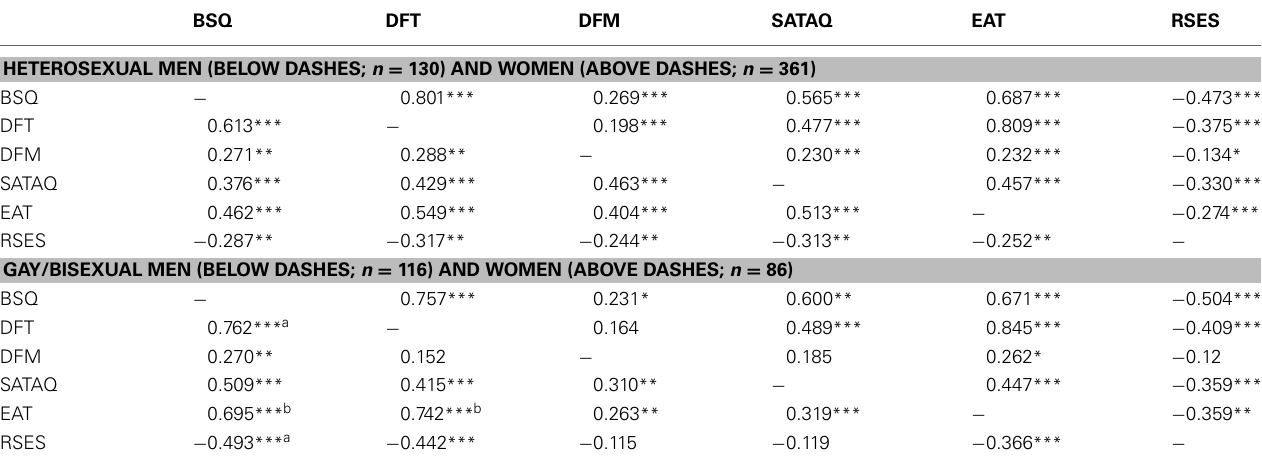
Table 5 | Spearman Rank-Order Correlations between each variable stratified by sex and sexual orientation. BSQ